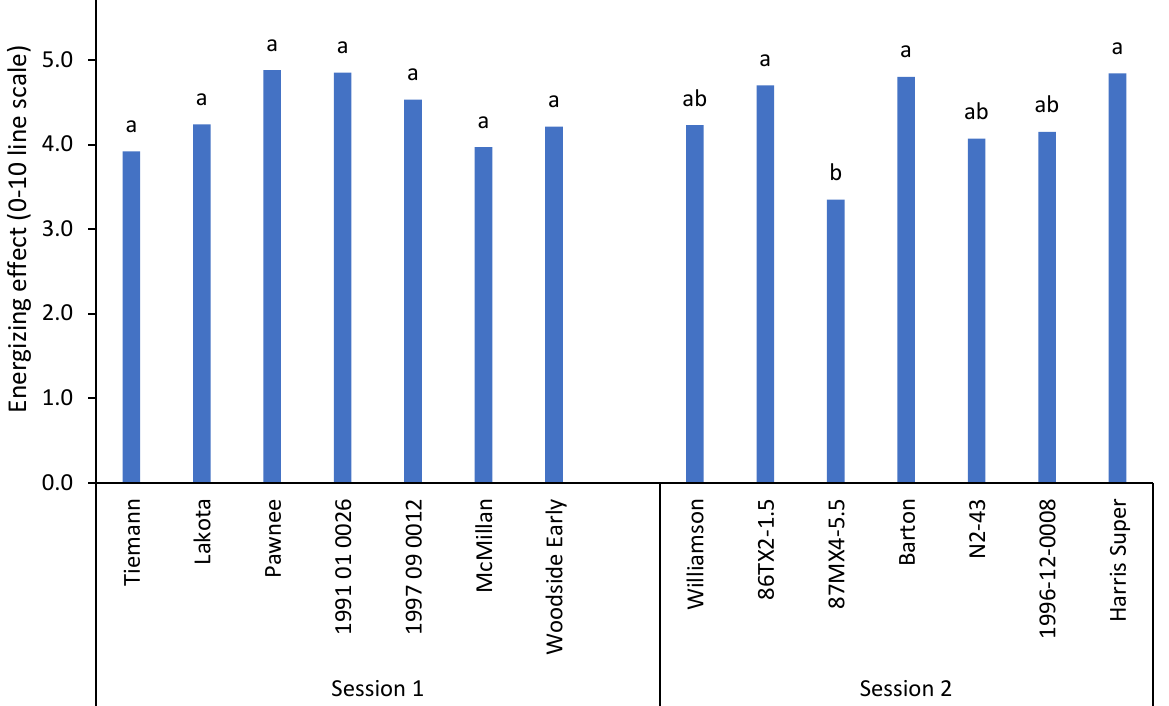
Figure 3. Consumer mean scores ( n = 99) for energizing effects of 14 pecan samples on a 0–10 line scale. Different letters (a,b) within attributes indicate significant differences between samples according to one-way ANOVA and Tukey’s HSD test.